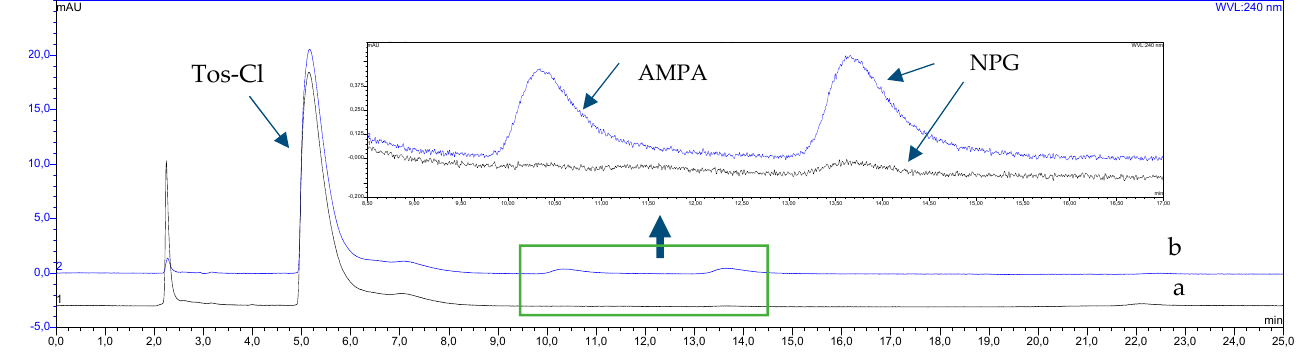
Figure 3. The HPLC chromatograms of the standard aqueous solution of AMPA and NPG before (a) and after UAE—SLM extract (b).